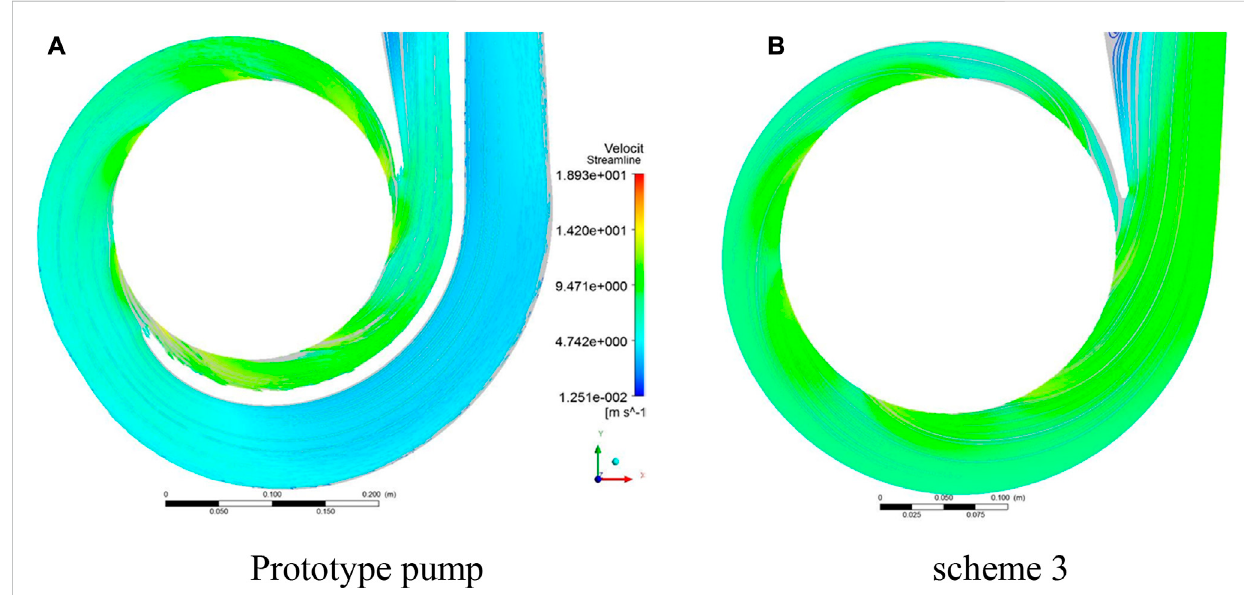
FIGURE 17 The static pressure and absolute velocity distribution on the X = 0 section in Scheme 3. (A) Static pressure distribution; (B) Absolute velocity